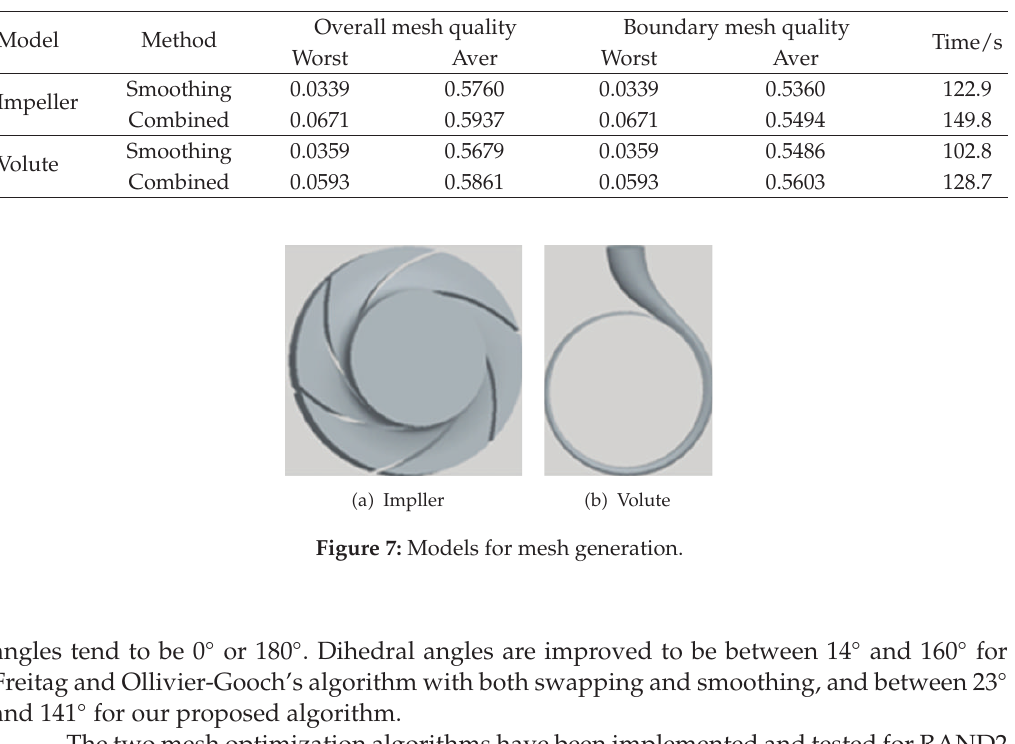
Table 2: Statistics of the examples after optimization.